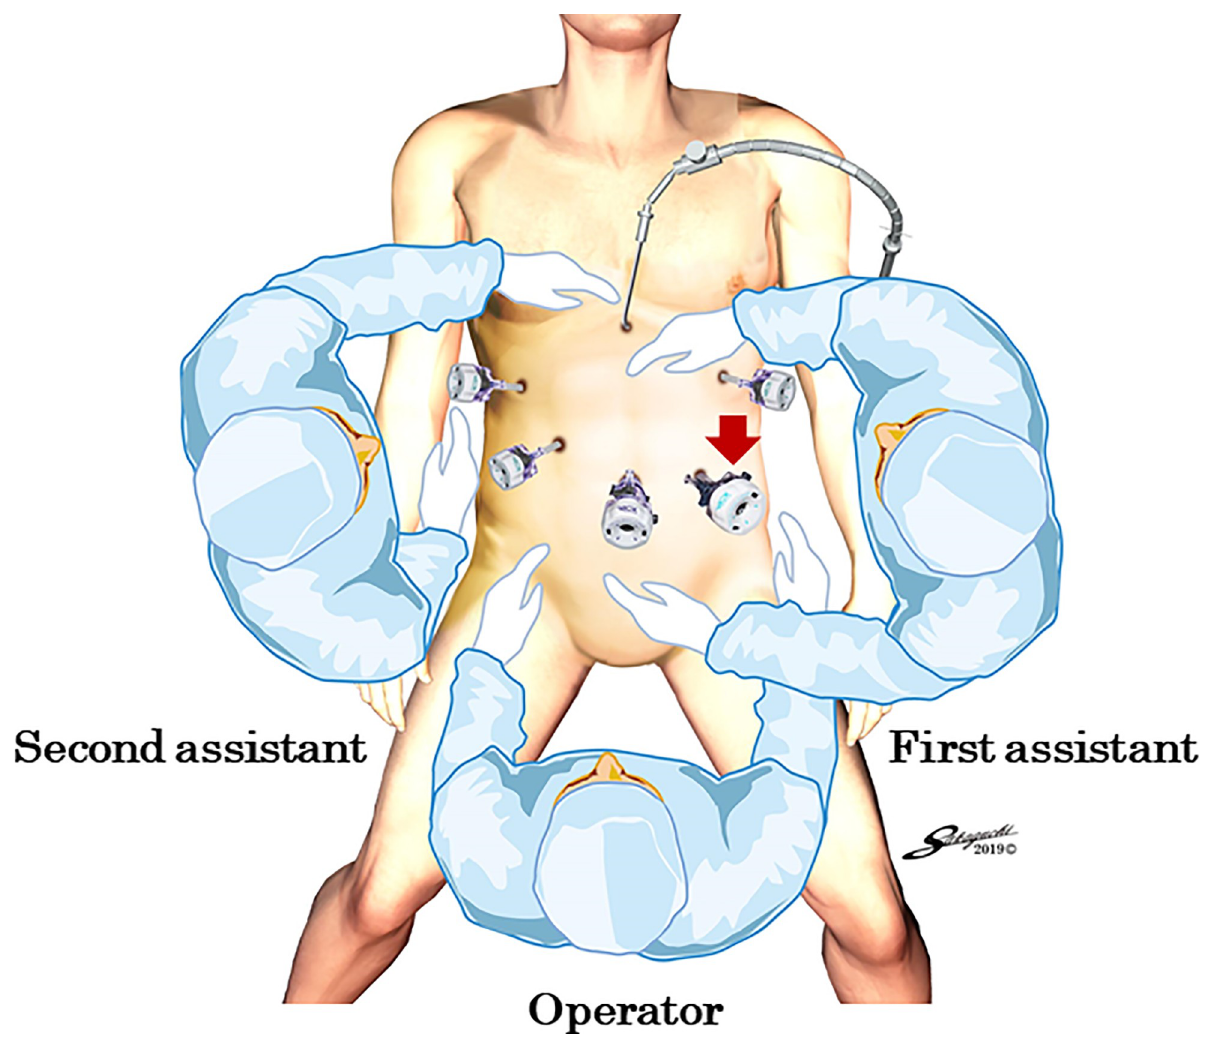
Fig 1. Port placements and positions of the operator and assistants. The stapler is inserted through the left lower port (red arrow), and all staplings are performed by the right hand of the operator positioned between the patient’s legs. duodenum. The operator inserted a 45-mm linear stapler into the remnant stomach with the right hand, and the first assistant pulled the staple line of the remnant stomach laterally. Then, the operator inserted the stapler into the duodenum with the right hand while pulling the sta- ple line of the duodenum laterally with the left hand. Linear stapling of the posterior walls of the remnant stomach and duodenum without creating a gap was performed, considering the prevention of intraoperative duodenal injury. Fig 4 shows linear stapling with a staple length of 30 mm. The operator closed the stapler entry hole with the right hand using a single-layer full-thickness suturing technique with knotted sutures and a knotless barbed suture after con- firming that there was no bleeding in the intraluminal V-shaped staple line, as we previously reported [15]. After removing the edge of the lesser curvature side of the stapler entry hole (Fig 5A), a full-thickness suture of 3–0 Prolene (Ethicon Endo-Surgery, Cincinnati, OH, USA) using the extracorporeal slip knot technique (Roeder’s knot) was placed on the lesser curvature side of the stapler entry hole [15]. After the second assistant retracted this knotted suture